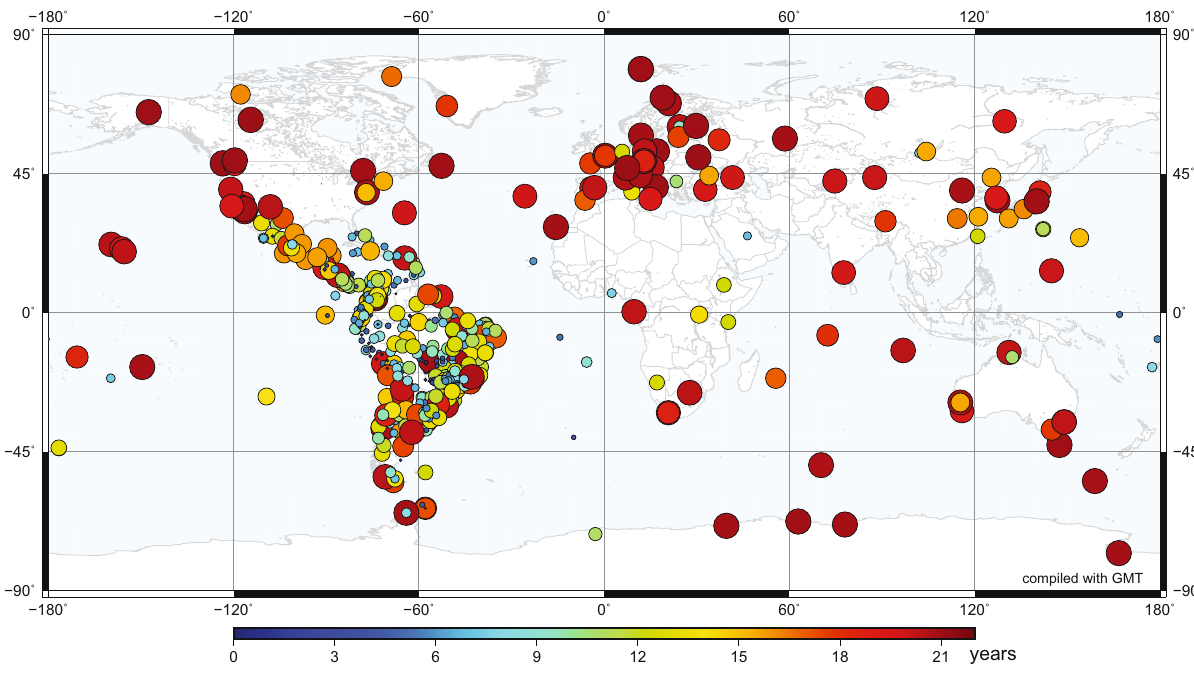
Figure 11: Time span of GNSS data included in SIRGAS - Repro2 per